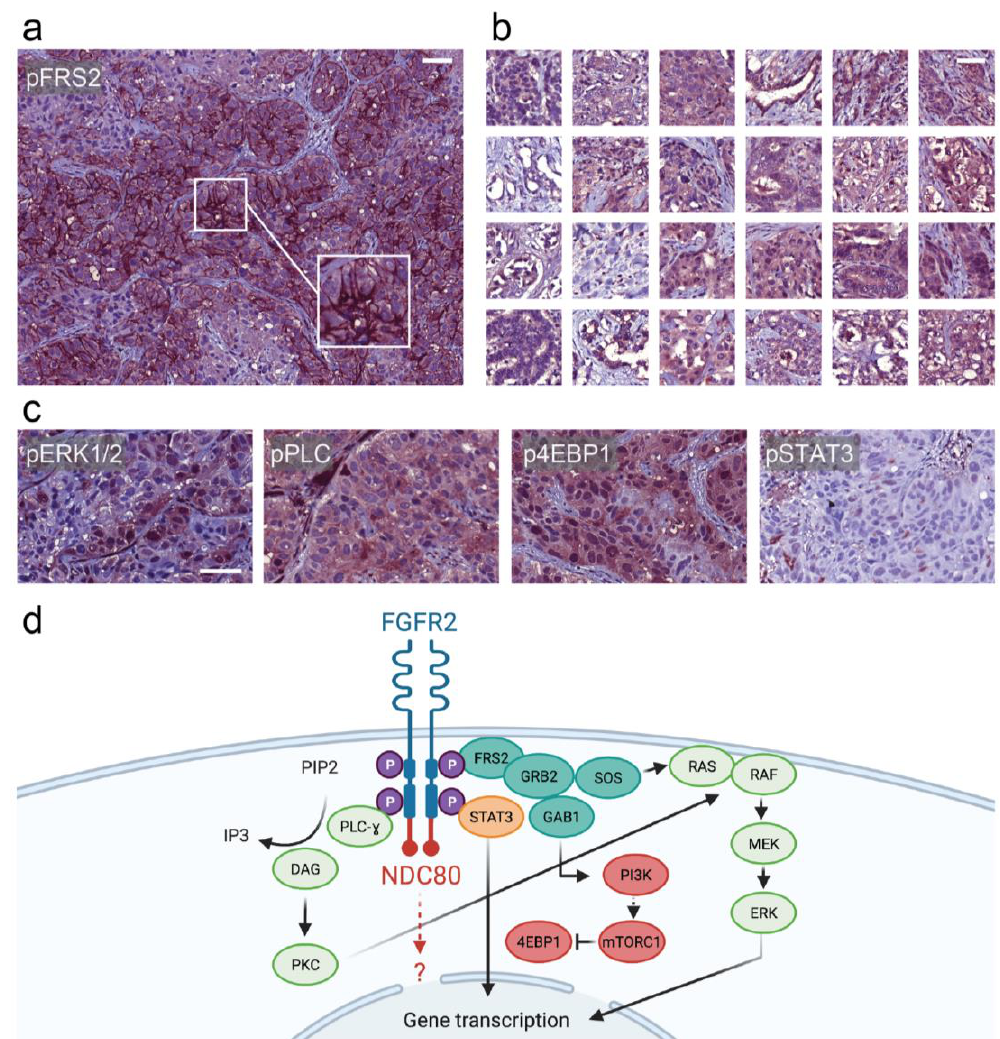
Figure 3 . Evaluation of downstream effector proteins. ( a ) pFRS2 immunostaining of the nodal metastasis showing strong membranous positivity. ( b ) pFRS2 immunohistochemistry of a self-made tissue microarray of cholangiocarcinoma specimens lacking strong membranous staining. ( c ) From left to right: pERK1/2-, pPLC-, p4EBP1-, and pSTAT3-immunohistochemistry of the nodal metastasis. Scale bars = 50 µm. ( d ) Schematic representation of a hypothetical ligand-independent activation of the FGFR-NDC80 fusion with downstream effectors.